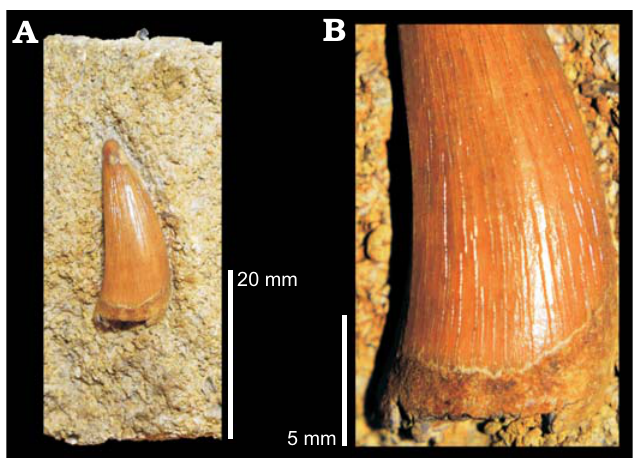
Fig. 12. Tooth of the metriorhynchid reptile Metriorhynchus superciliosus de Blainville, 1853 (NHMUK PV OR 47044) from Heddington (Wiltshire), Corallian, in labial view ( A ), close up of labial ornamentation ( B ).